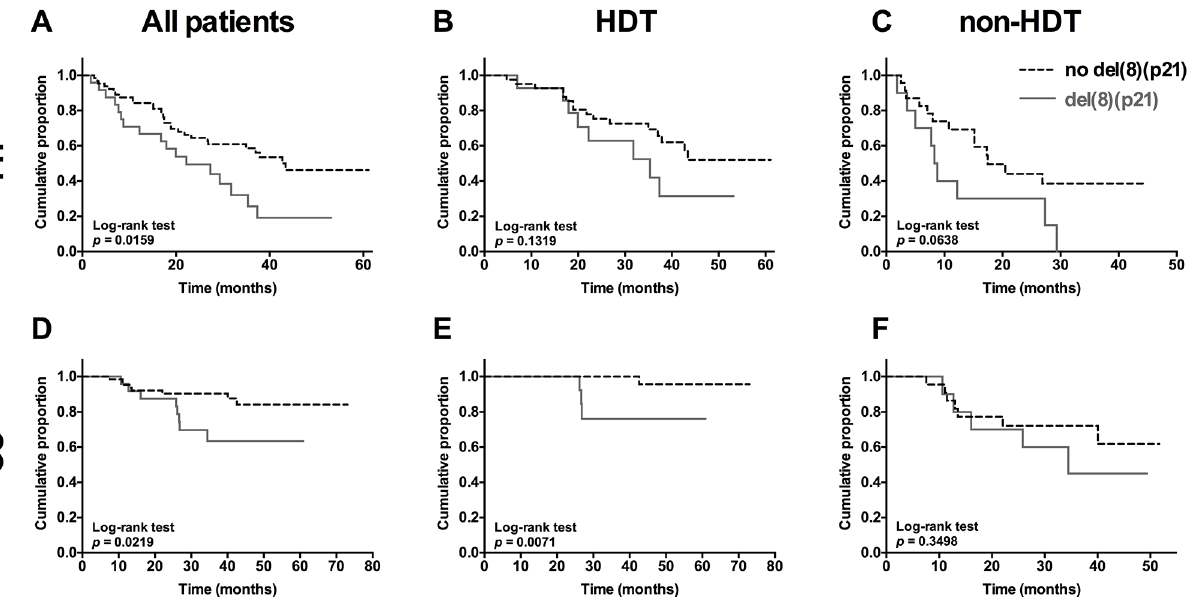
Fig 1. Multiple myeloma patients with del(8)(p21) have poor TTP and OS. Time to progression (TTP) of (A) all patients, (B) HDT patients, (C) non-HDT patients after diagnosis (months). Overall survival (OS) of (D) all patients, (E) HDT patients, (F) non-HDT patients after diagnosis (months). Patients with del (8)(p21) (n = 24). Patients without del(8)(p21) (n = 64). HDT patients with del(8)(p21) (n = 14). HDT patients without del(8)(p21) (n = 41). Non-HDT patients with del(8)(p21) (n = 10). Non-HDT patients without del(8)(p21) (n = 23). Log-rank (Mantel-cox) test performed using Graphpad Prism software.